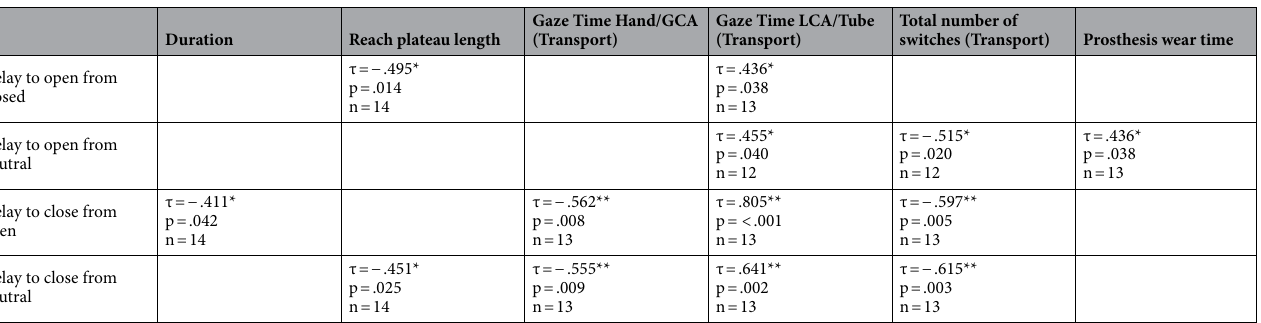
Table 2. Kendall’s tau-b correlation matrix (2-tailed), comparing the electromechanical delay in the prosthesis to a sub-selection of the outcome measures. Only significant correlations with τ values > 0.3 or < -0.3 are shown. ** Correlation is significant at the .01 level. *Correlation is significant at the .05